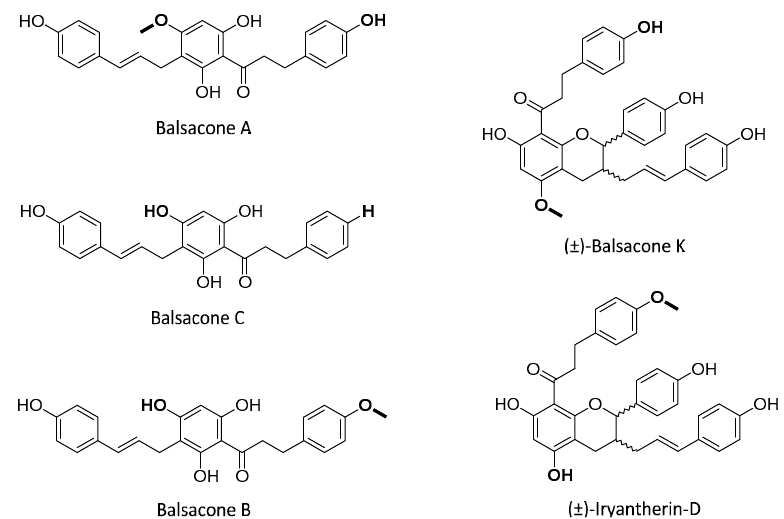
Figure 1. Structure of balsacone A, balsacone B, balsacone C, ( ± )-balsacone K, and ( ± )-iryantherin-D.